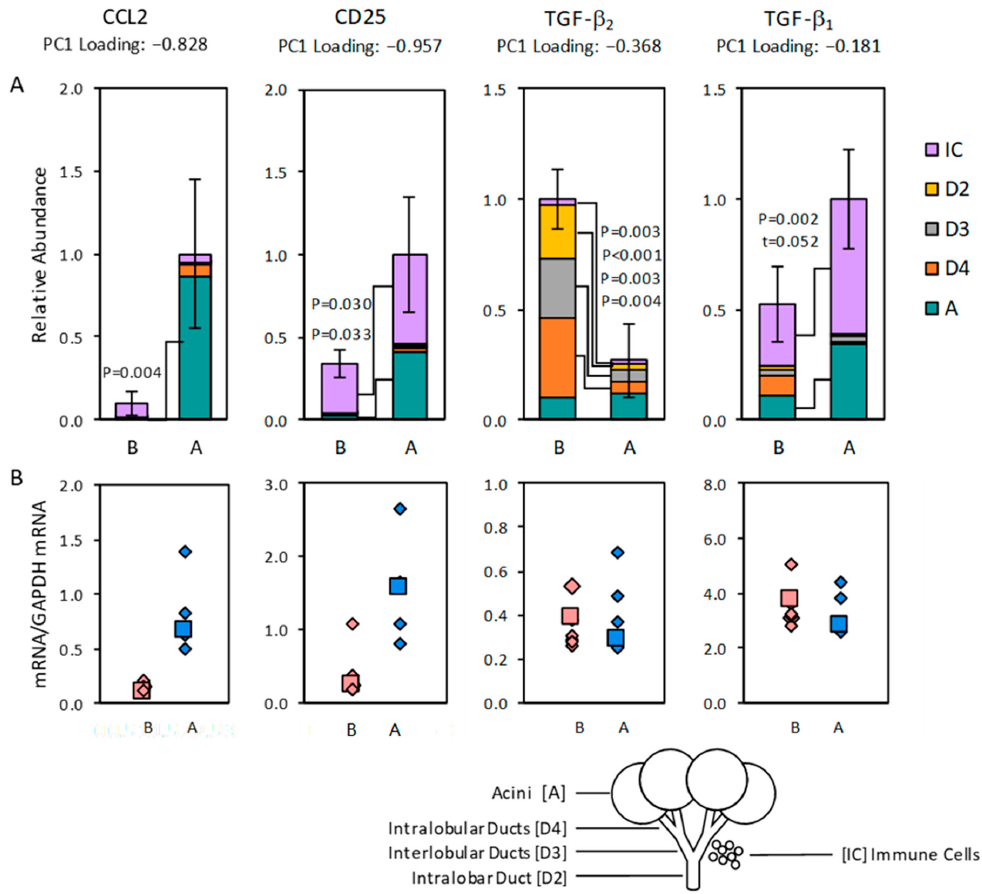
Figure 5. ( A ) Modeled abundances of selected transcripts in samples of immune cells (IC), intralobar duct cells (D2), interlobular duct cells (D3), intralobular duct cells (D4), and acinar cells (A) microdissected from representative subgroup P.G5.B glands (positive PC1 projection in Figure 2) and a representative subgroup P.G5.A gland (negative PC1 projection in Figure 2). Error bars indicate pooled standard errors for IC and the four epithelial elements. The transcripts selected showed statistically significant differences between epithelial segments from the P.G5.A gland and the P.G5.B glands (significant p -values and p -values indicating trends (t) are as indicated). ( B ) Measured abundances of the transcripts in whole-gland samples of the P.G5.B and P.G5.A subgroup glands. Glands that were microdissected are indicated by large-font symbols.